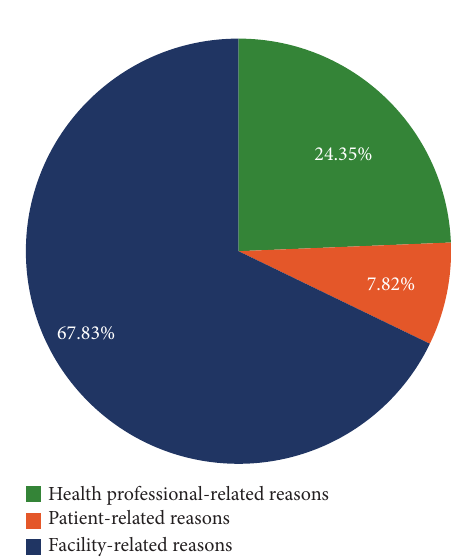
Figure 1: Pie chart showing the percentage distribution of factors contributing to cancellation of elective surgeries by